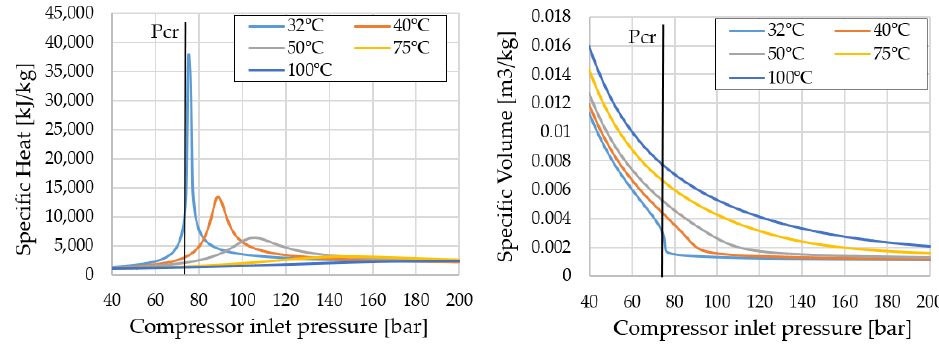
Figure 3. Trends of the thermo-physical properties of CO 2 in the vicinity of the critical